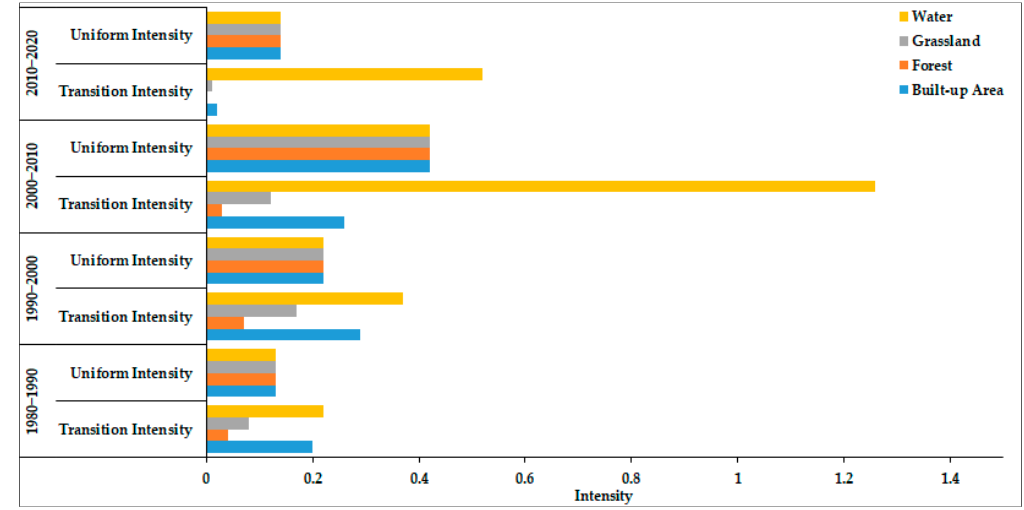
Figure 13. Transition to Cropland. Table 22. Transition to Cropland.